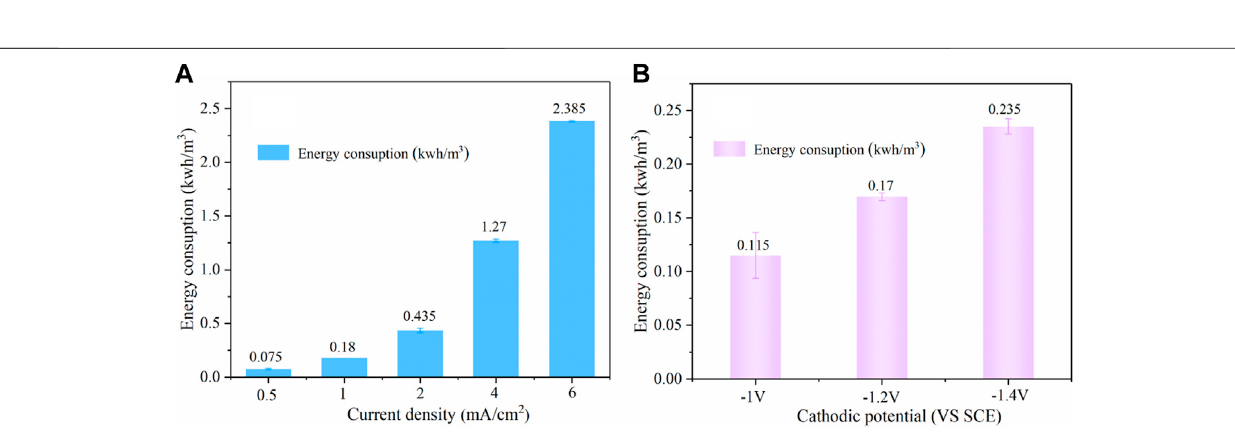
Frontiers in Chemistry |